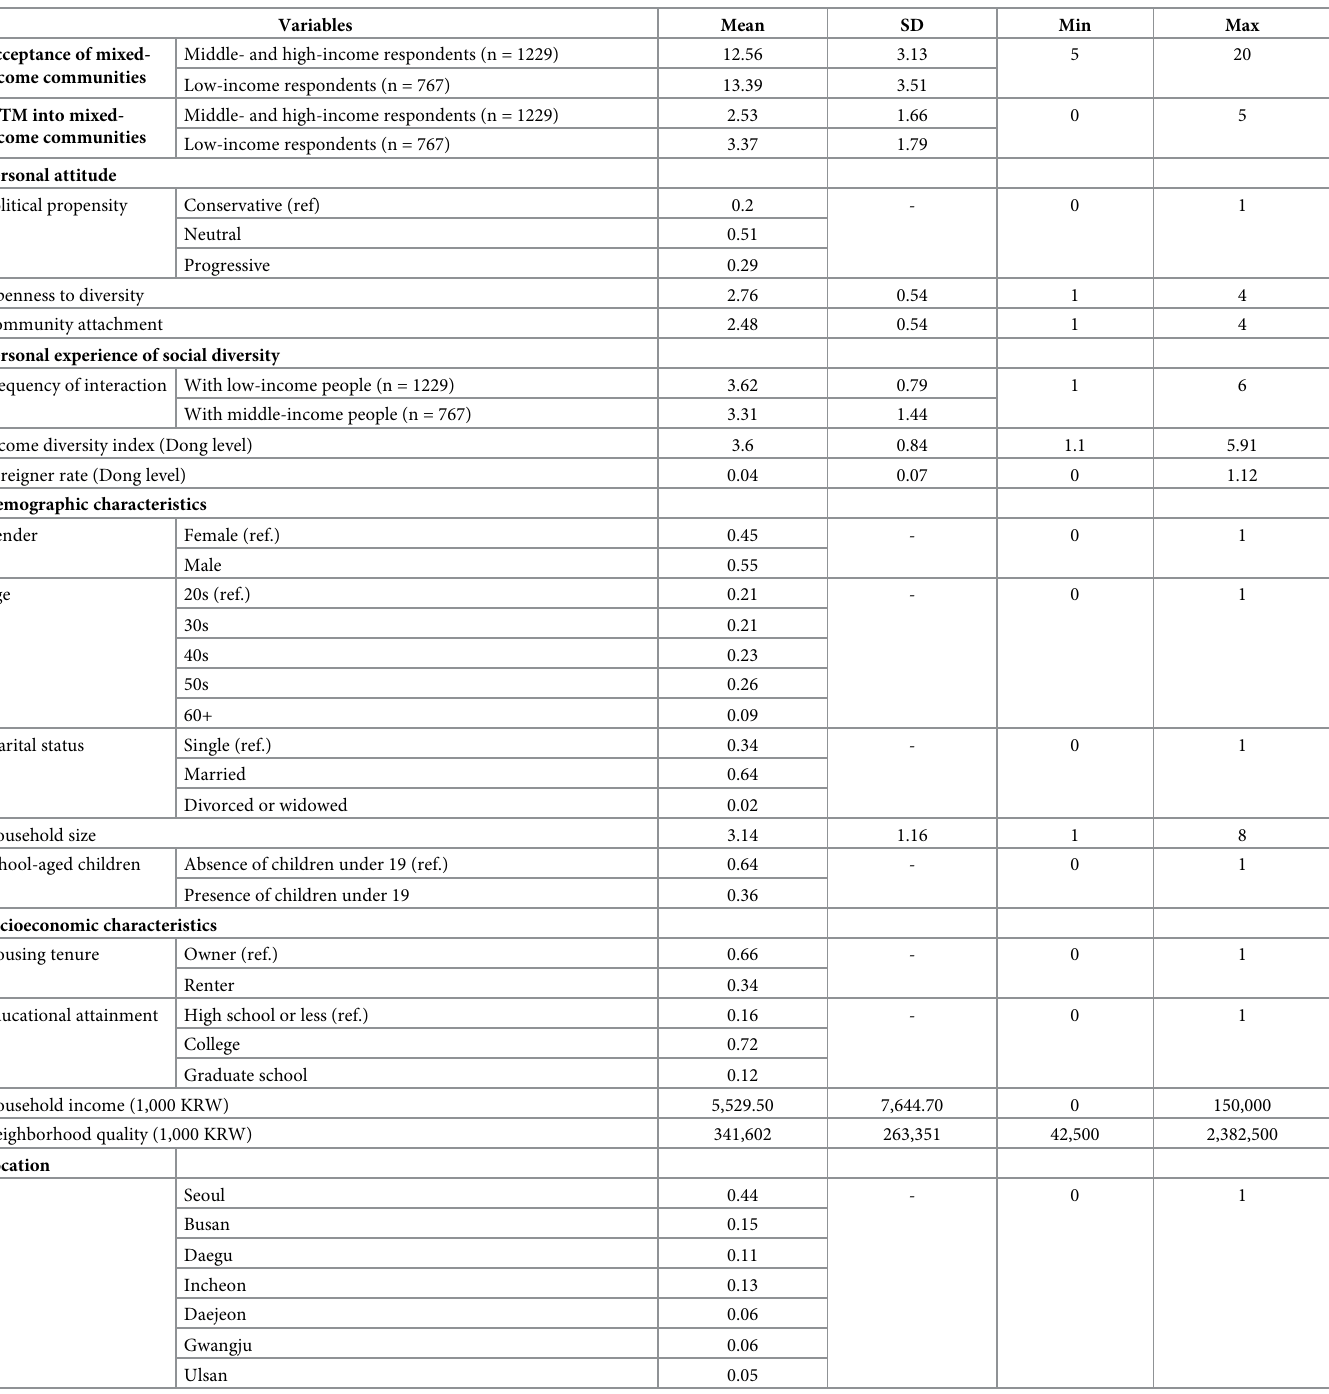
Table 2. Summary statistics of variables (n =